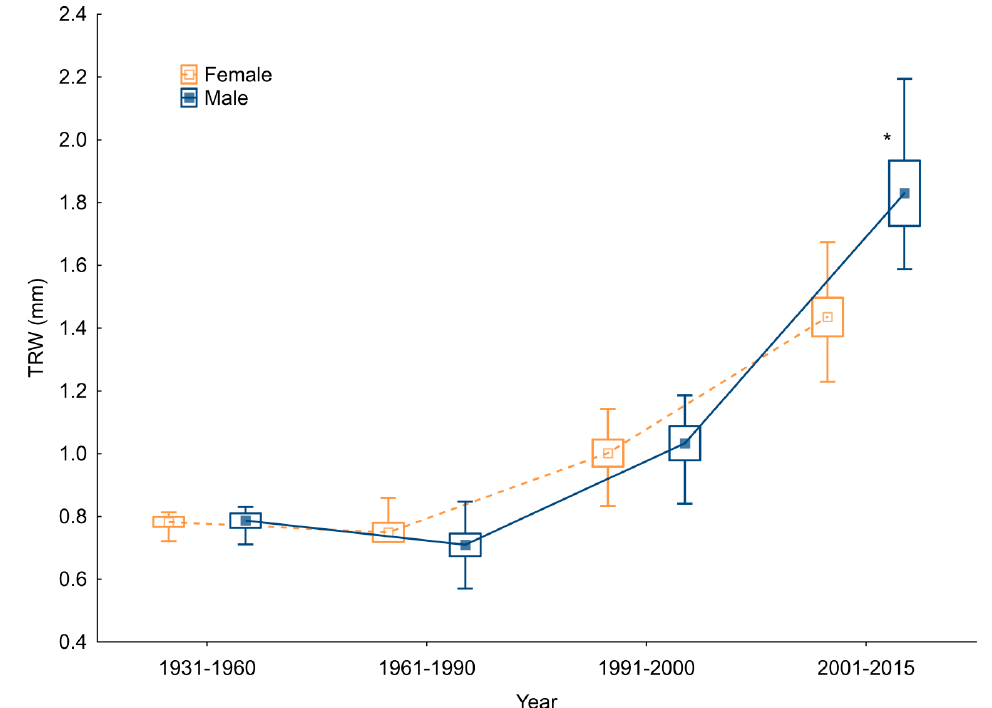
Figure 6. Comparison of mean periodic radial increments according to sex. Boxes represent standard deviations and whiskers range of TRW values; * denotes a significant difference between male and female yews.